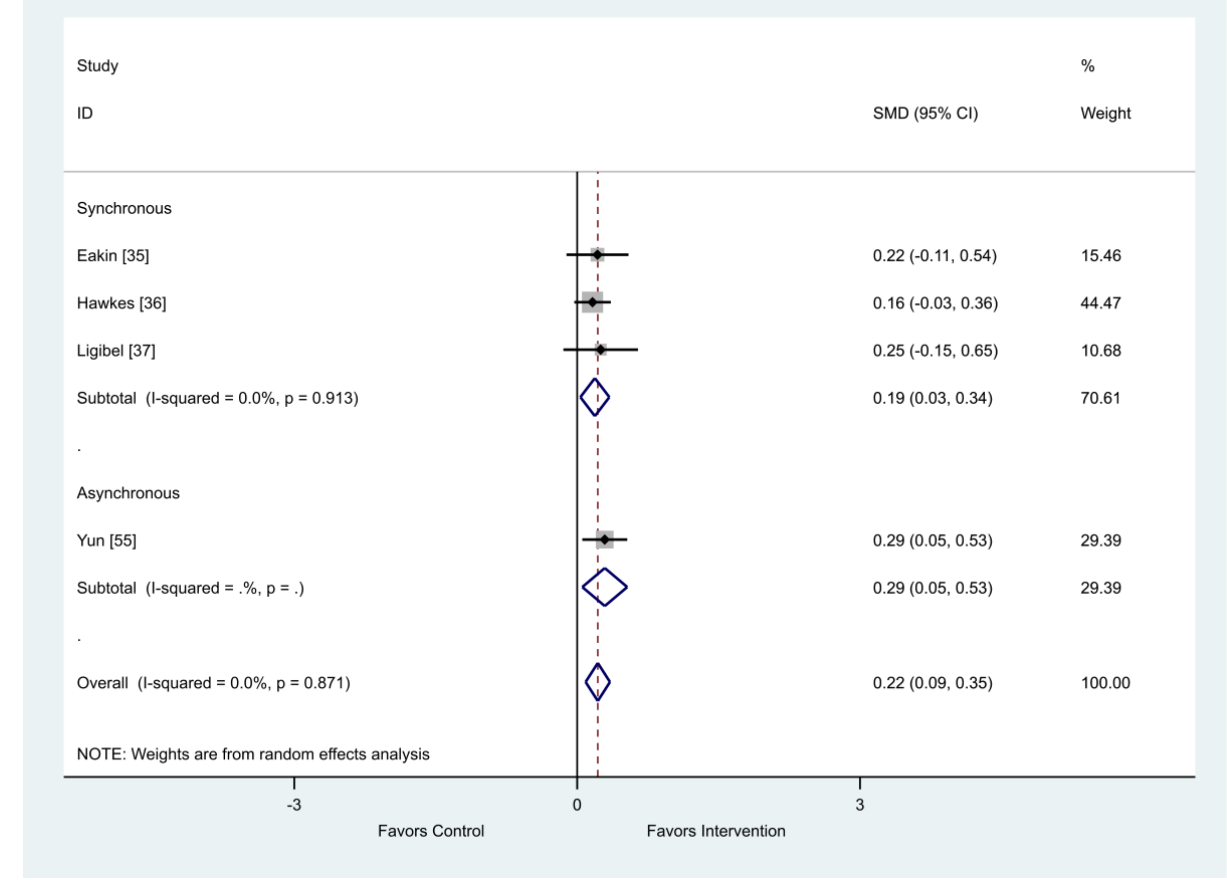
Figure 9. Effect of electronic health interventions with a control on fatigue interventions, analyzed using standardized mean difference (postintervention mean and SD change scores). Lower scores indicate improved fatigue. SMD: standardized mean difference.